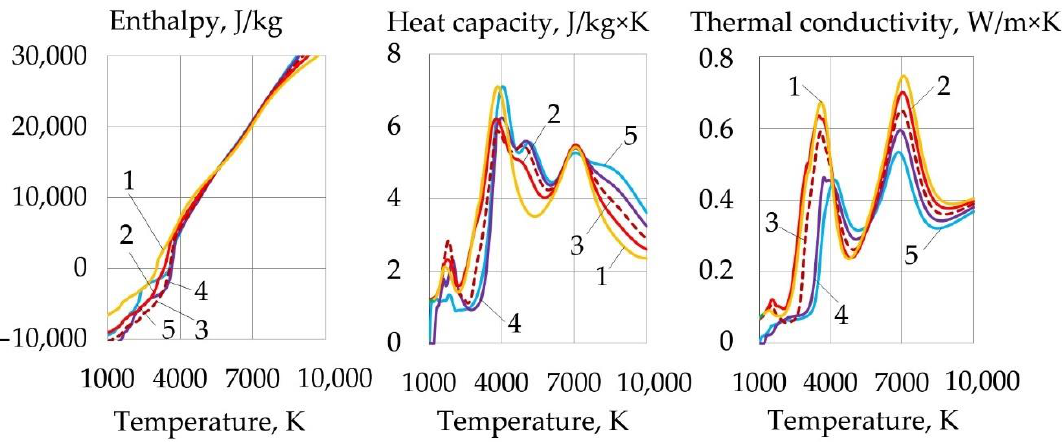
Figure 11. Thermophysical properties of plasma for component mixtures, wt.%: ( 1 ) 40FeCO 3 + 40KNO 3 + 20Na 3 AlF 6 ; ( 2 ) 35FeCO 3 + 35KNO 3 + 20Na 3 AlF 6 + 10Al; ( 3 ) 30FeCO 3 + 30KNO 3 + 20Na 3 AlF 6 + 20Al; ( 4 ) 25FeCO 3 + 25KNO 3 + 20Na 3 AlF 6 + 30Al; ( 5 ) 20FeCO 3 + 20KNO 3 + 20Na 3 AlF 6 + 40Al.